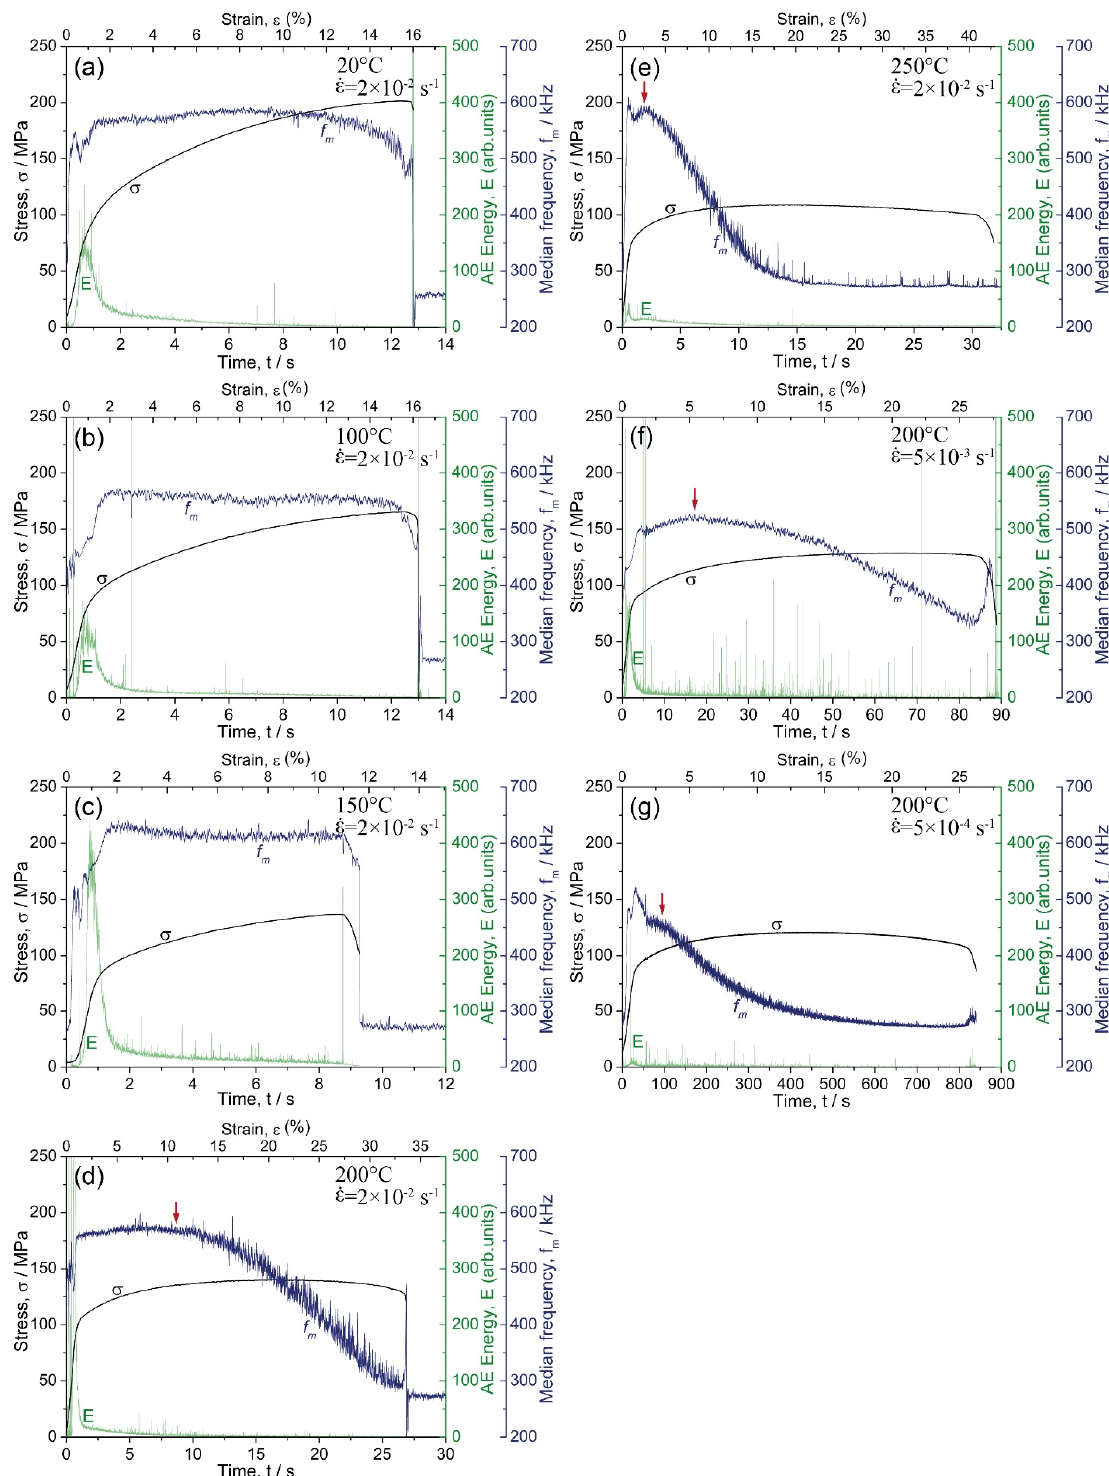
Figure 7. The AE energy and median frequency behaviour as a function of deformation time (strain) in tension at 2 × 10 − 2 s − 1 strain rate and testing temperatures 20 ( a ), 100 ( b ), 150 ( c ), 200 ( d ) and 250 °C ( e ); plots ( f ) and ( g ) show the same parameters for testing at 200 °C and ε = 5 × 10 − 3 s − 1 and 5 × 10 − 4 s − 1 , respectively. Arrows in ( d )–( g ) indicate the breakpoints in the f m trends from ascending to descending at the strain ε AE cr